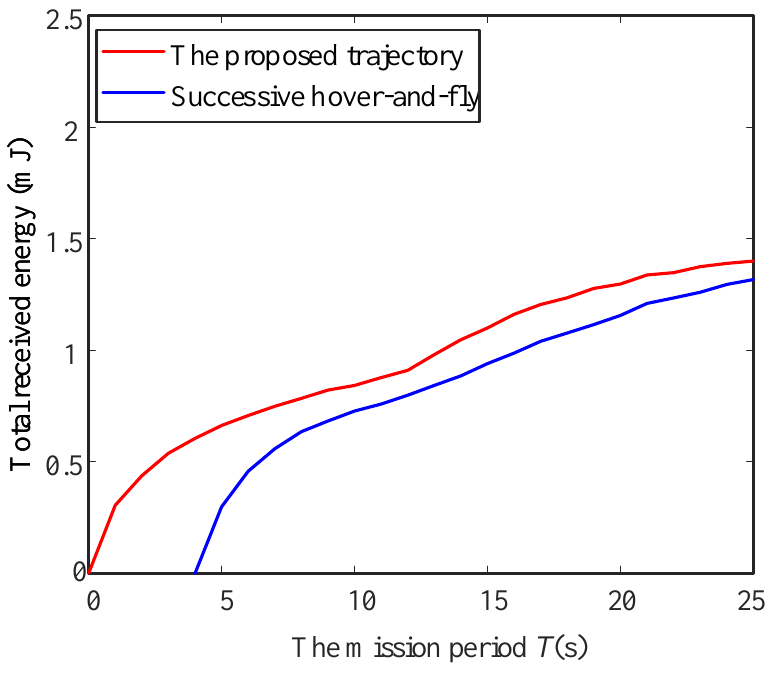
Figure 9. The total received energy between the proposed optimal path algorithm and the successive hover-and-fly trajectory